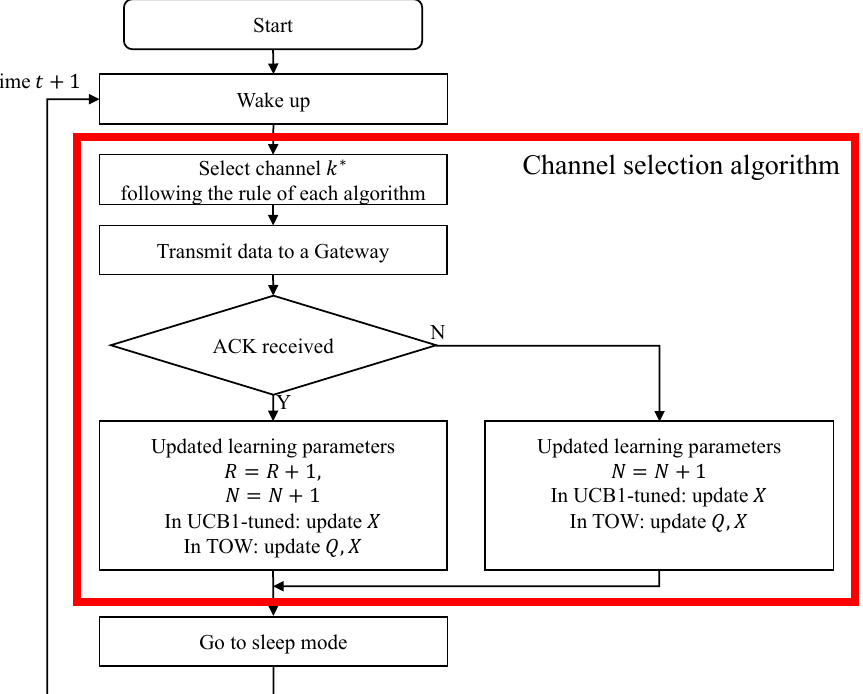
Figure 5. Flowchart of the channel